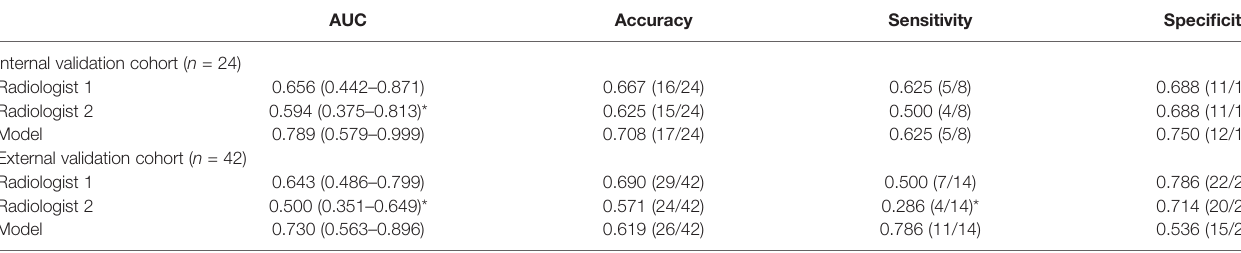
TABLE 3 | The detailed comparison between the performance of two radiologists and the combined model.